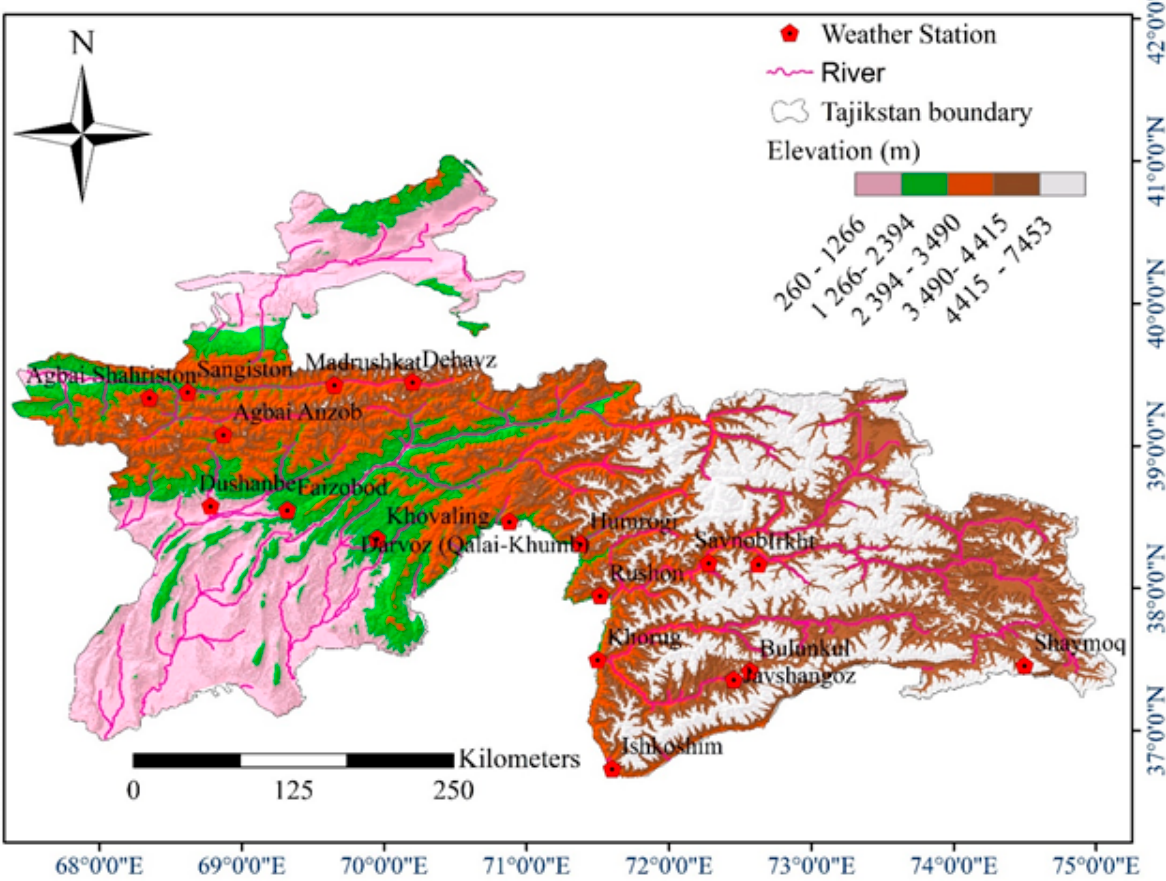
Figure 1. Topographic map and applied gauging stations of Tajikistan.